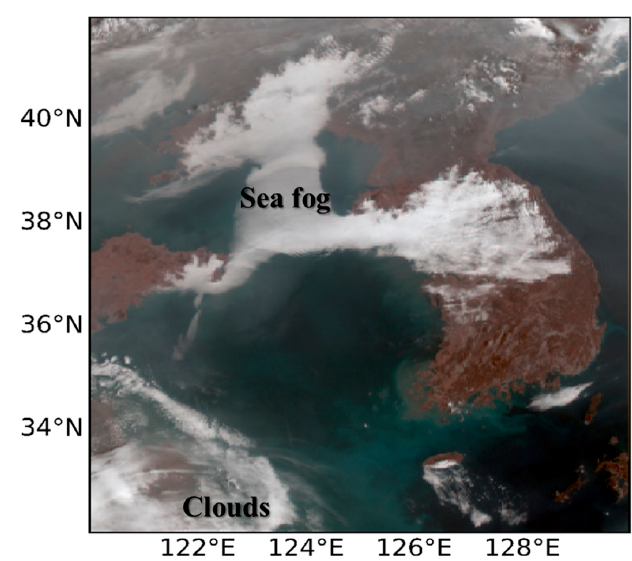
Figure 1. Study area of the Yellow Sea. The Red-Green-Blue (RGB) image observed from the Advanced Himawari Imager (AHI) sensor shows sea fog and clouds on 14 March 2018, 00:30 UTC (09:30 Korean Standard Time (KST)). Table 1. Characteristics of the AHI channels.